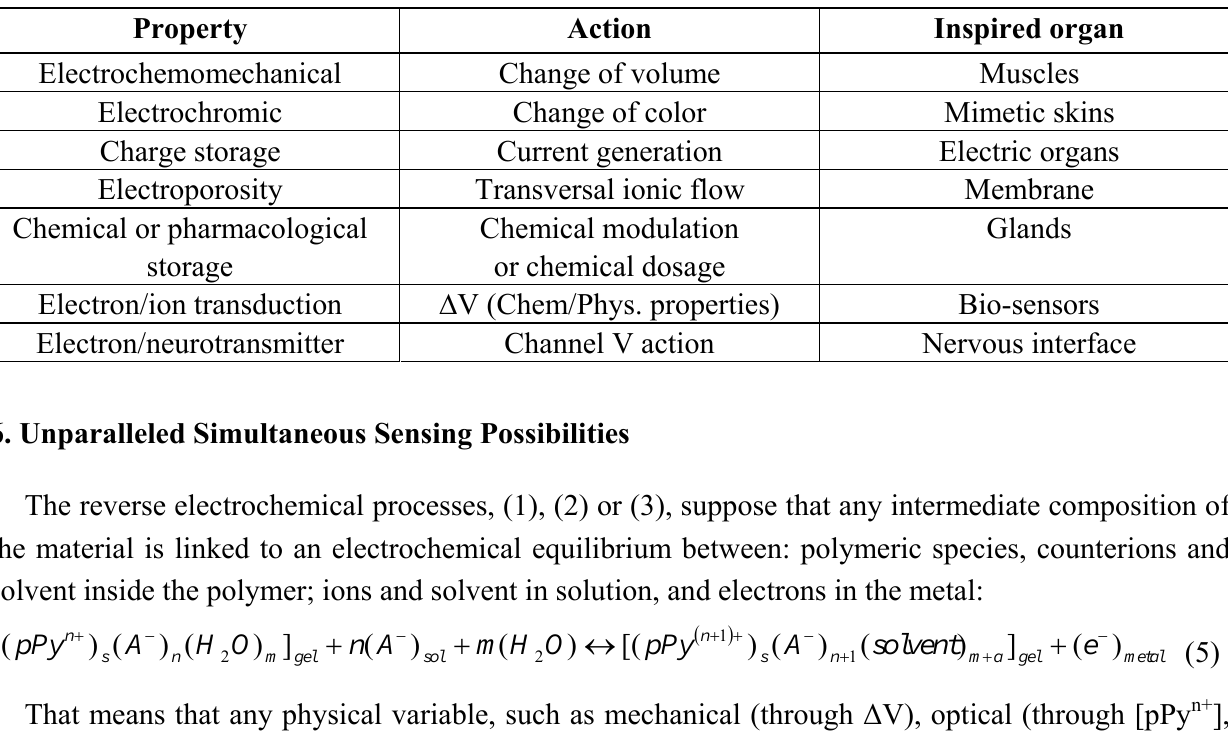
Table 1. Electrochemical properties of conducting polymers, related functions and minded biological